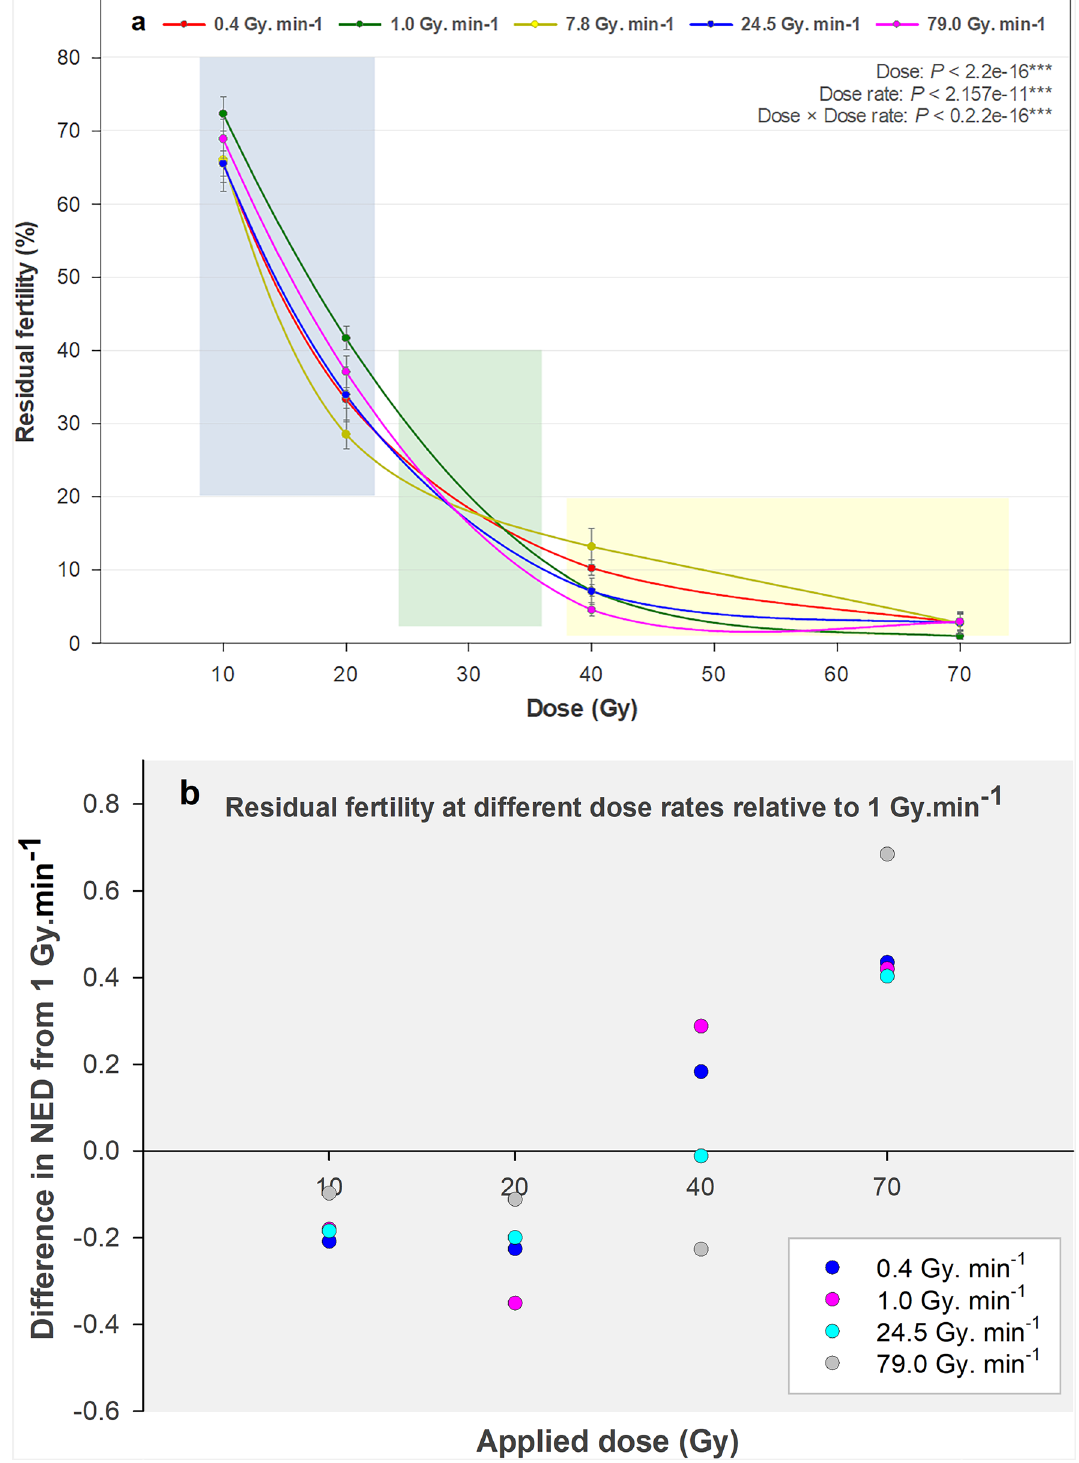
Figure 2. ( a ) Interaction of dose and dose rate: a zone with a positive correlation of the two factors (yellow zone: low doses and increasing dose rates), a negative correlation with inverse dose rate effect (green zone: high doses, with increasing dose rates) and a zone where there are no effects of dose rate (blue zone: mid-range doses). The best model predicting the hatch rate used the log of the dose, the dose rate use as a factor in three groups [0.4; 1; 7.8 Gy min −1 or more] and their interaction. It demonstrated that at a low dose, a dose rate of 0.4 Gy min −1 or 7.8 or more Gy min −1 was more efficient at reducing hatch rate than a dose rate of 1 Gy min −1 (p < 10 –3 ). The opposite was observed when the dose increased, with a changeover point between 20 and 40 Gy, the dose of 1 Gy min −1 becoming the most efficient at inducing sterility (p < 10 –3 ). ( b ) Absolute differences in fertility levels (expressed as normalized equivalent deviates, NED) at the various dose rates relative to 1 Gy min −1